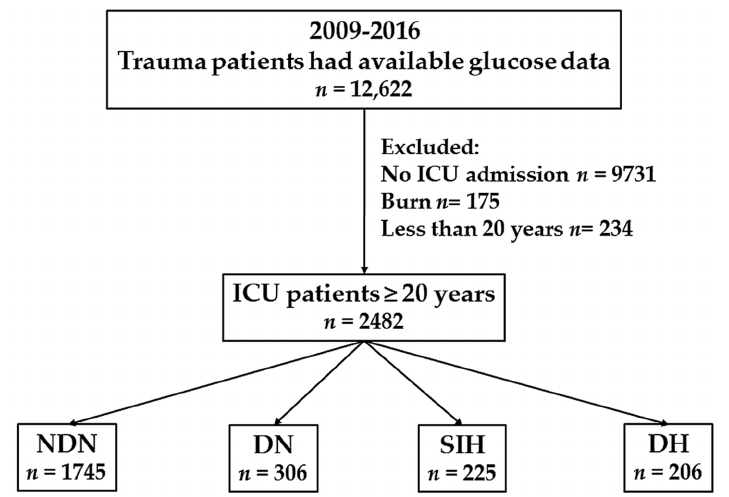
Figure 1. Flowchart of the allocation of patients into the non-diabetic normoglycemia (NDN), diabetic normoglycemia (DN), stress-induced hyperglycemia (SIH) and diabetic hyperglycemia (DH) groups according to the existence of hyperglycemia (serum glucose level ≥ 200 mg/dL) and DM